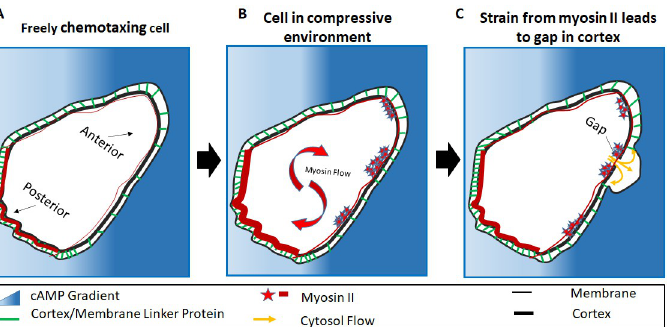
to compression from the environment. Myosin is attracted by the cAMP causing a forward recruitment. it then forms clusters at the anterior. C) Myosin contractions results in cortex degradation, a gap forms weakening the connection to the membrane. The bleb follows at the